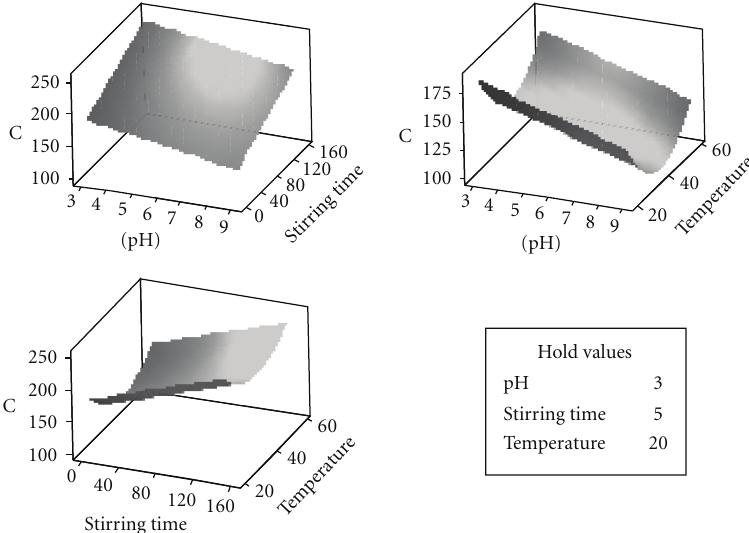
Figure 3: Surface plots of concentration of leached copper. Table 7: Design matrix of the Box-Behnken design.